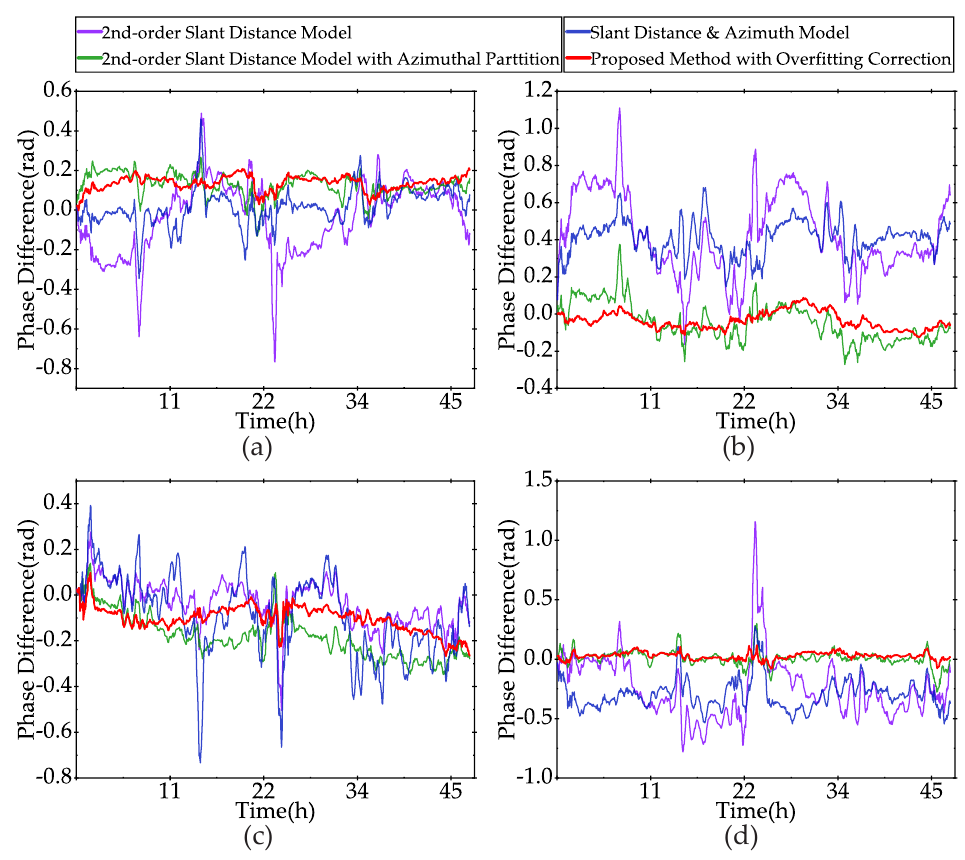
Figure 18. Phase difference curves between the median curves of CP for the four areas and the simulated deformation curve, ( a – d ) are the difference curves of A–D in Figure 16, respectively. Table 4. The standard deviation of the phase difference curves in Figure